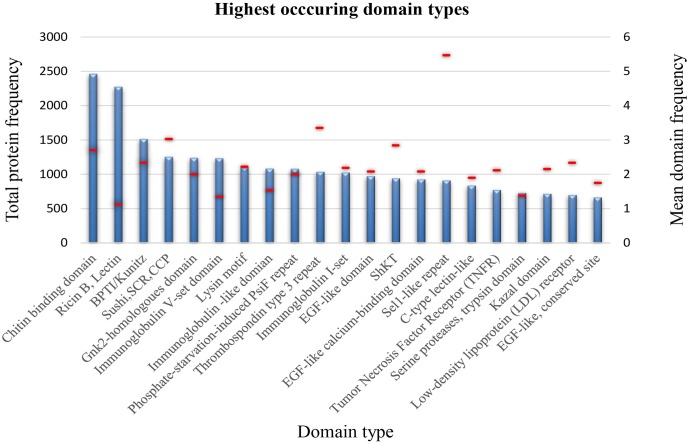
SCREP structural diversity. Distribution of the 20 highest occurring domain types identified by InterPro within the refined SCREPs population, showing frequency of proteins within an individual domain type (blue), and the mean domain frequency (red line overlay).